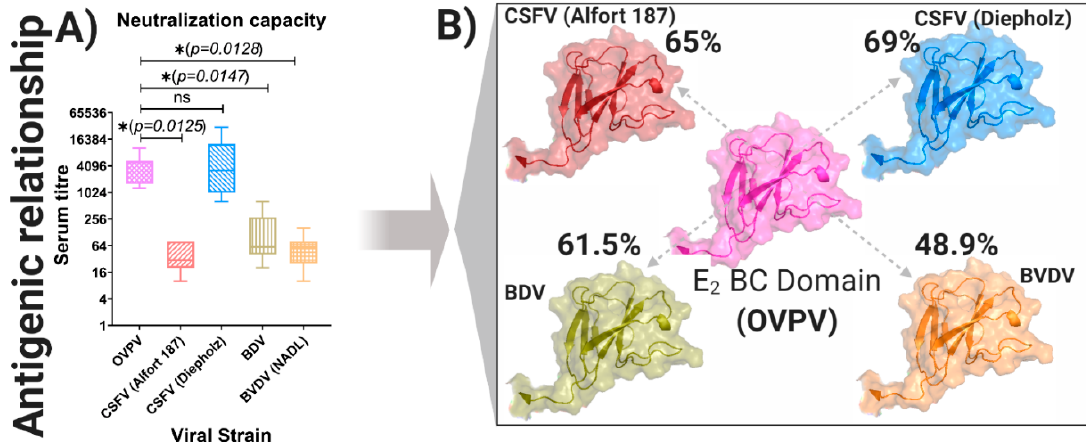
Figure 6. Antigenic relationship among the novel OVPV and other Pestivirus members. ( A ) Neutralization capacity deduced from the serum–antigen interactions (see Table 2). Mean values were compared by Brown–Forsythe Welch ANOVA test with multiple comparisons using